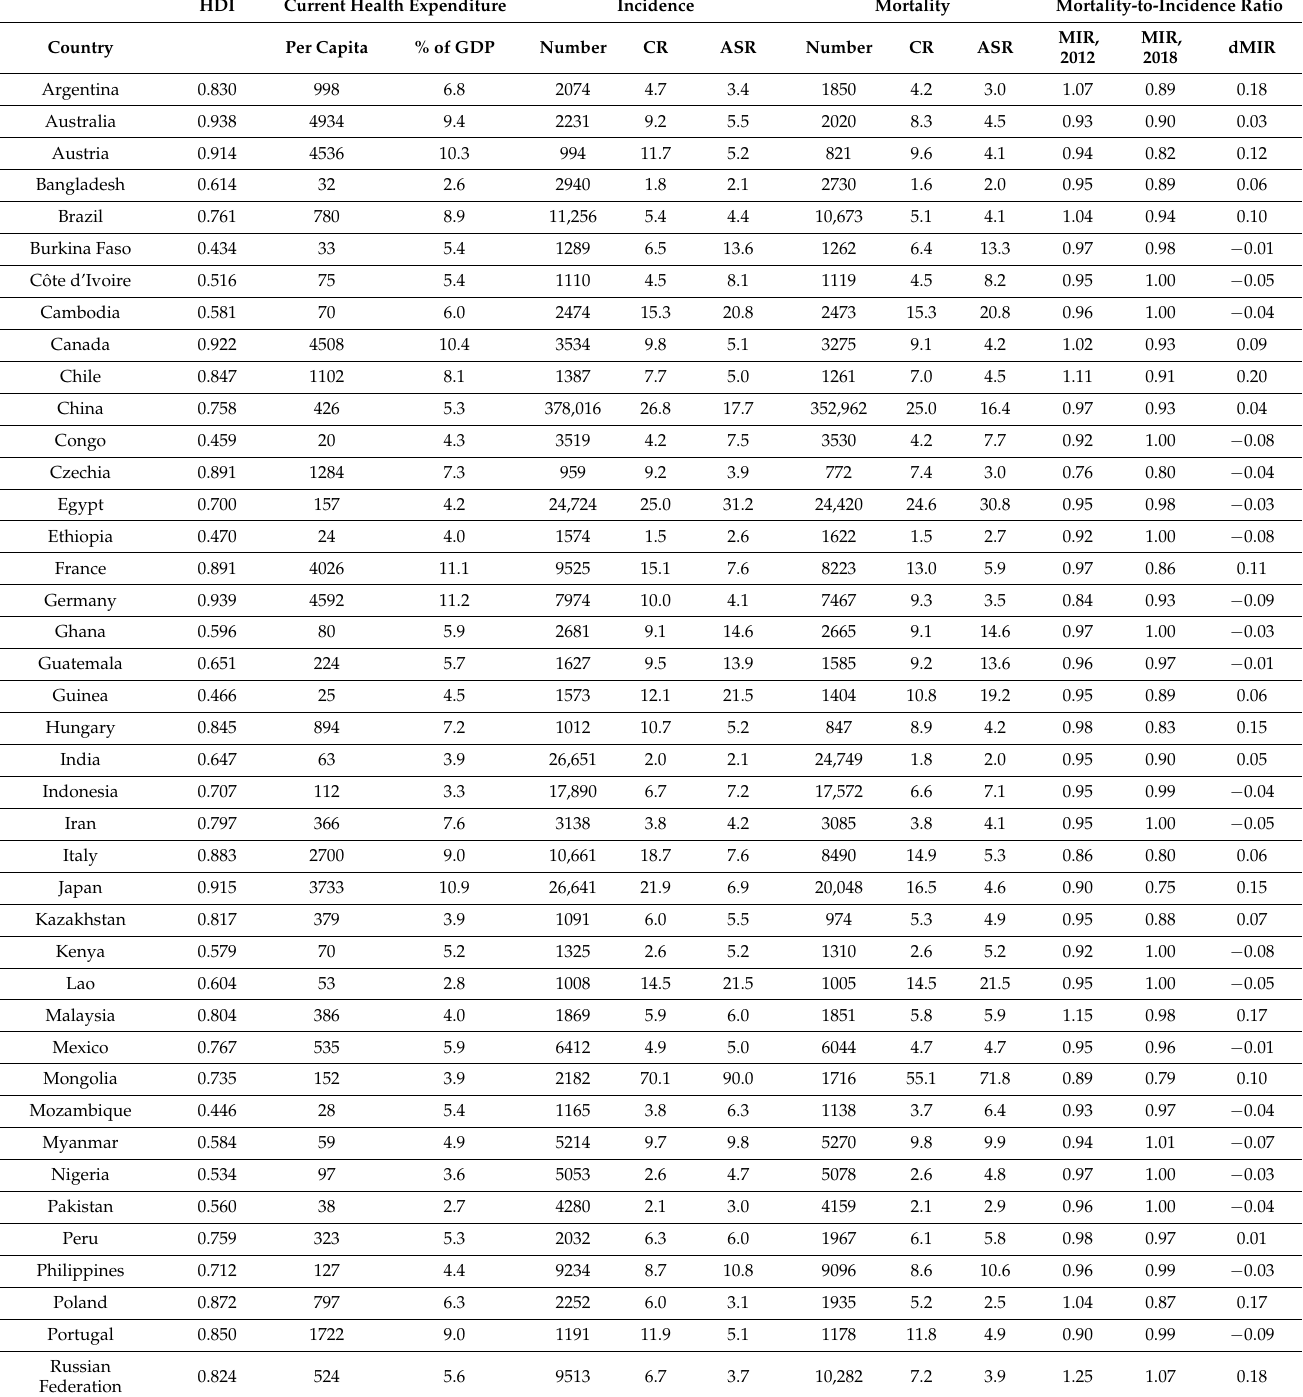
Table 2. Summary of human development index (HDI), current health expenditure, cancer inci- dence, cancer mortality, and mortality-to-incidence ratio in liver cancer of selected countries with incidence number > 923, the mean of all countries (n =